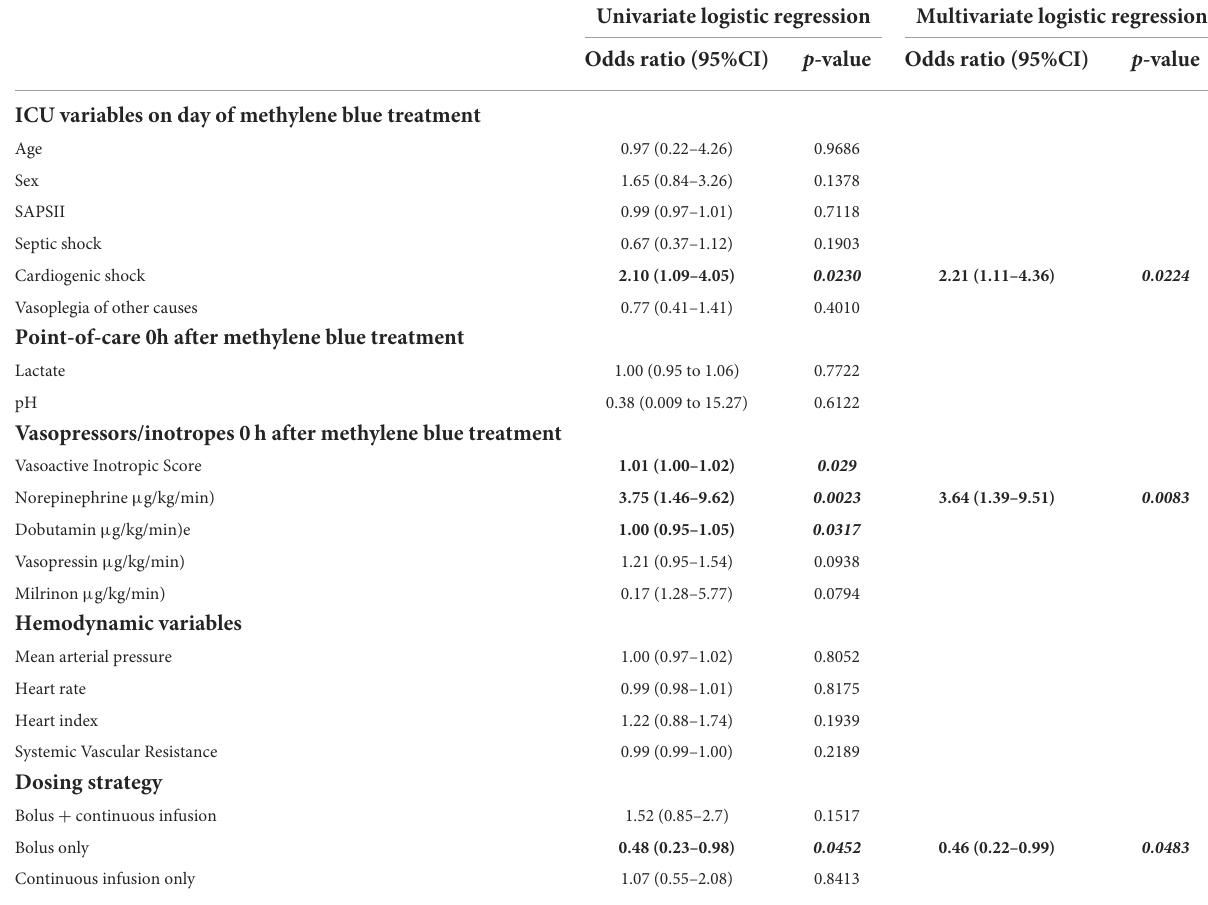
TABLE 3 Factors associated with methylene blue response in the logistic regression.